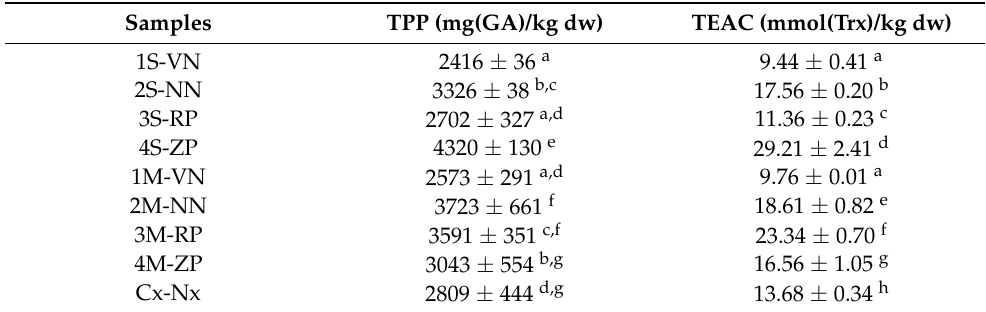
Table 3. Values of Total Polyphenols (TPP, mg(GA)/kg dw) and Trolox Equivalent Antioxidant Capacity (TEAC, mmol(Trx)/kg dw) of hydroalcoholic extracts (MeOH/H 2 O; 80:20%, v/v ) of peaches and nectarine mesocarp samples. The values are expressed as mean ± SD ( n = 27). Values marked with the same letter within the same column are not statistically different (Tukey’s test, p > 0.05). Samples